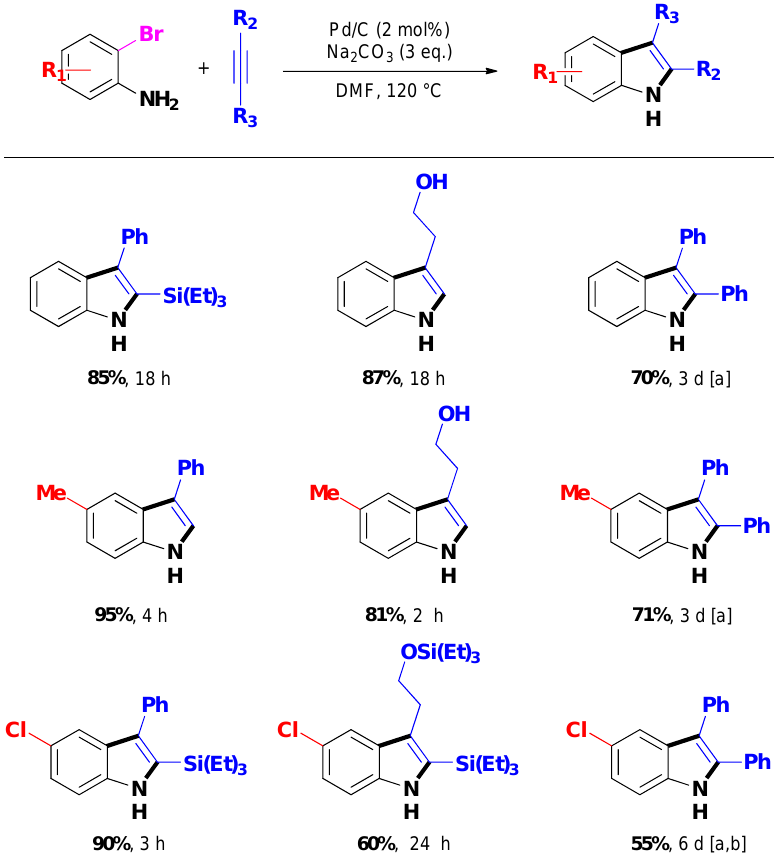
Larock heteroannulation of 2-bromoanilines through heterogeneous additive-free